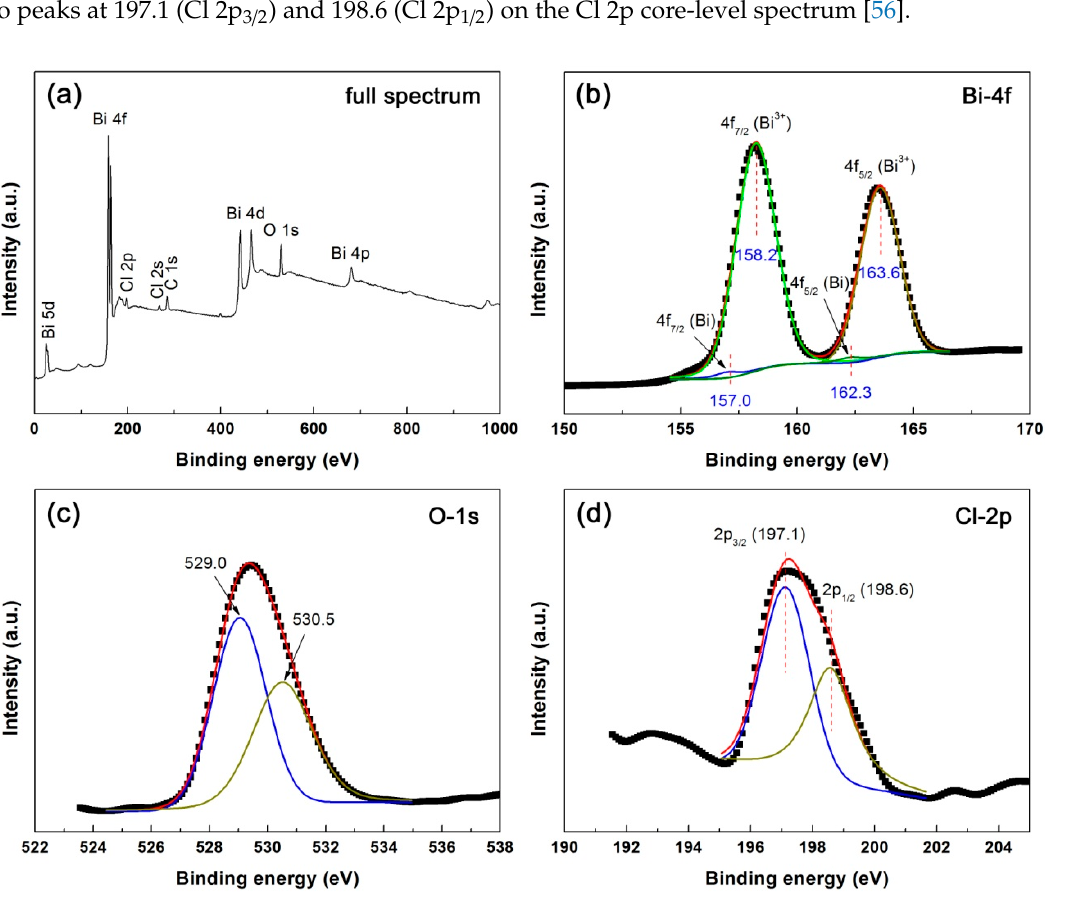
Figure 5. Survey scan XPS spectrum ( a ) and high-resolution XPS spectra of ( b ) Bi 4f, ( c ) O 1s and ( d ) ( d ) Cl 2p of Cl 2p of 30mM-30min-BiOCl.